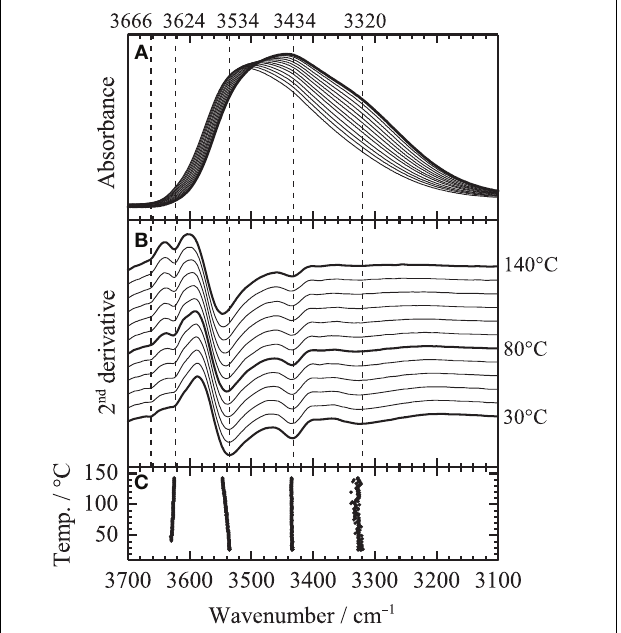
FIGURE 2 | (A) Close up of Figure 1 in the O-H stretching region, (B) second derivative spectra and (C) peak position of the second derivative spectra. Bold line in (A) corresponds to the spectrum at 25 ◦ C.